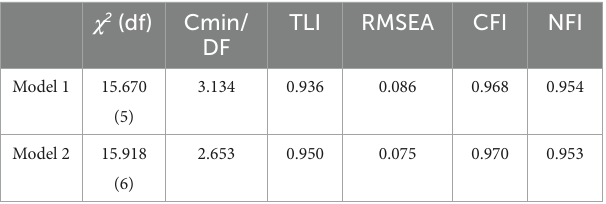
TABLE 8 Goodness of fit indices for the path